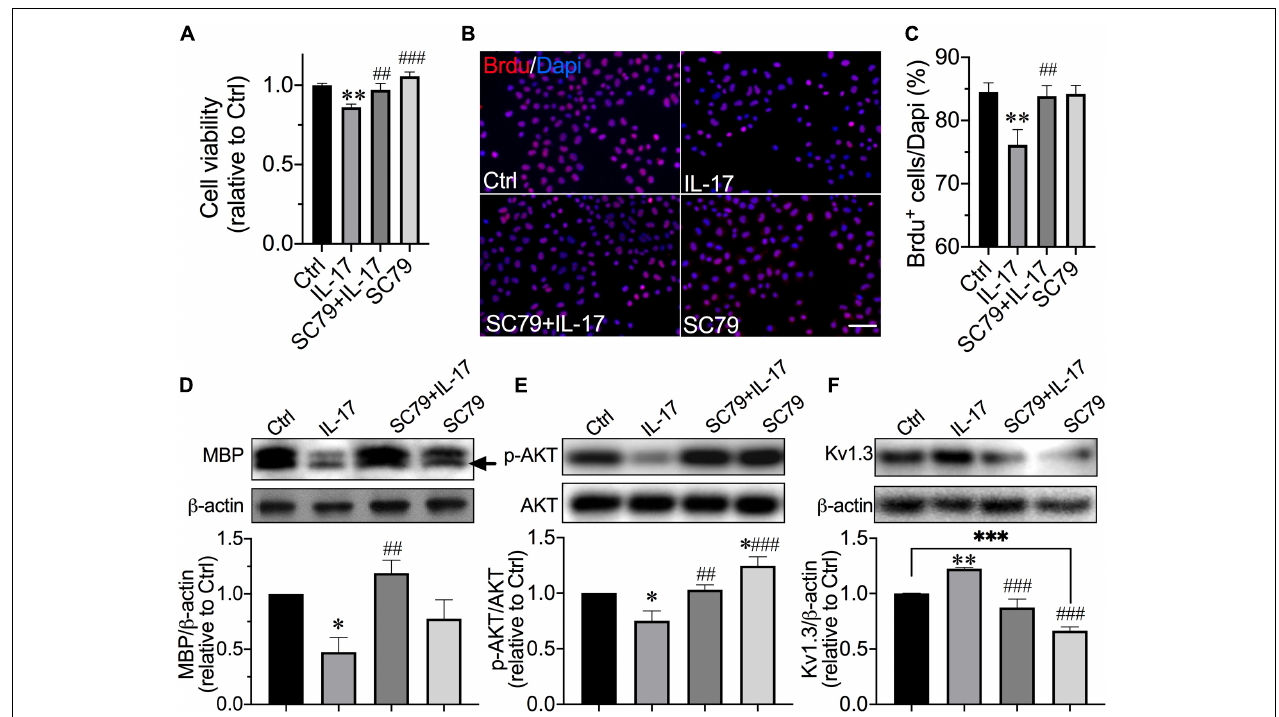
FIGURE 4 | Protection of AKT activator on IL-17–induced inhibition of OPC proliferation and differentiation. OPCs were exposed to IL-17 (200 ng/mL) for 48 h with or without AKT activator SC79 (10 µ M). (A) MTT assay was performed to detect OPC viability ( n = 7). SC79 counteracted the decrease in cell viability induced by IL-17. (B) OPCs were treated as described before in the presence of BrdU (10 µ M) for 48 h. Representative images of merged BrdU immunofluorescence staining (red) and DAPI (blue) are shown. Scale bar = 20 µ m. The average percentage of BrdU + cells from five independent experiments are summarized in (C) There were 10 randomly selected visual fields counted for each experimental group from three independent treatments. IL-17–induced reduction of BrdU + cell percentage was attenuated by SC79. For experiments conducted with Ols in (D–F) , OPCs were exposed to IL-17 (200 ng/mL) with or without SC79 (10 µ M) in OPCDM for 6 days. (D–F) Representative images and statistical analyses of MBP ( n = 4), p-AKT ( n = 4), and Kv1.3 ( n = 5) expressions in Ols of Western blot. Band densitometry data are shown in the bar graph (below). SC79 effectively activated AKT signal in our culture system. Similar to the PAP, SC79 counteracted the IL-17–induced decrease in MBP and increase in Kv1.3 expression and mitigated the decrease in p-AKT induced by IL-17. ∗ P < 0.05 vs. control, ∗∗ P < 0.01 vs. control, ∗∗∗ P < 0.001 vs. control. ## P < 0.01 vs. IL-17, ### P < 0.001 vs.